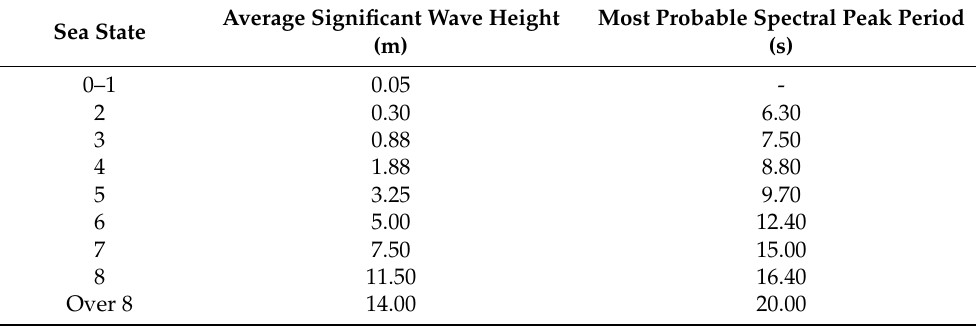
Table 2. Significant wave height and spectral peak period applied to the